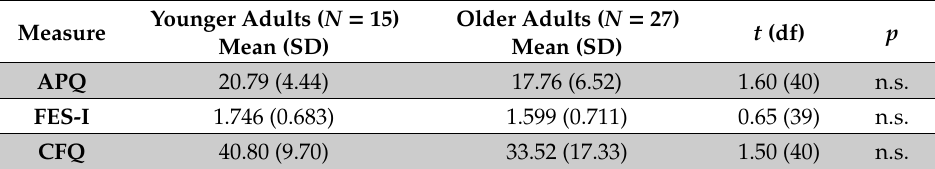
Table 1. Mean APQ, FES-I and CFQ scores for younger and older adults.